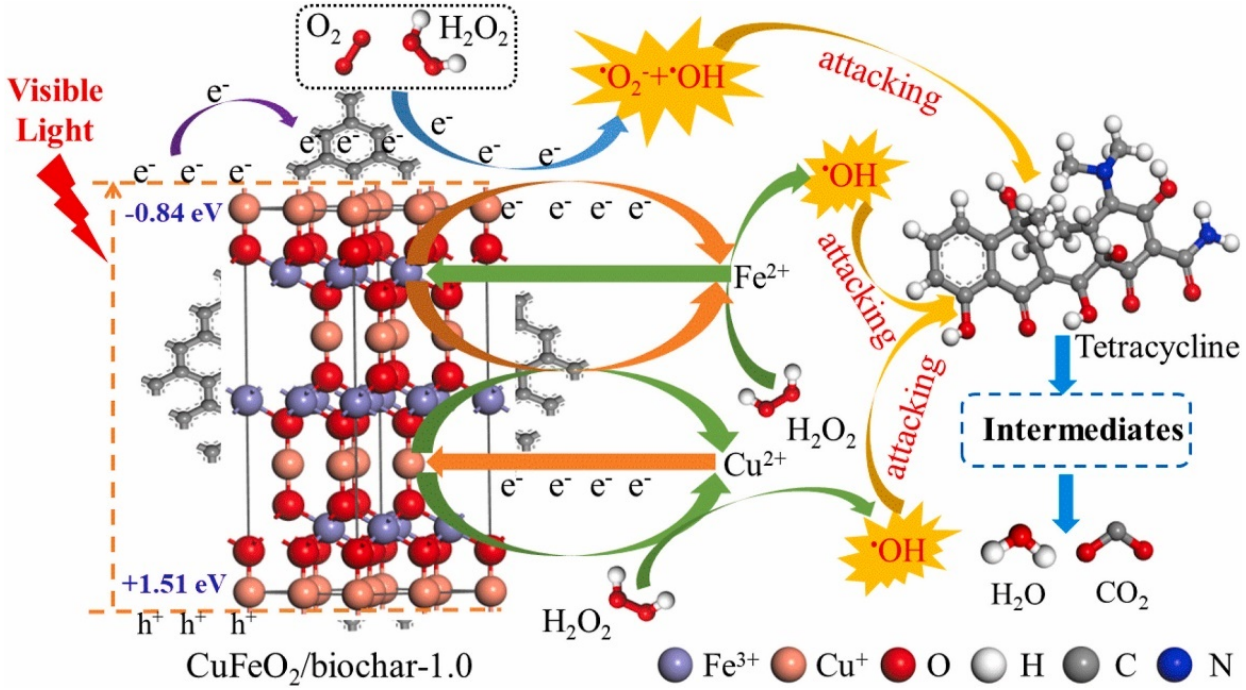
Figure 5. Possible mechanism of tetracycline degradation by CuFeO 2 /biochar in the heterogeneous photo–Fenton system. Reprinted with permission from Ref. [38]. Copyright 2020, Elsevier.